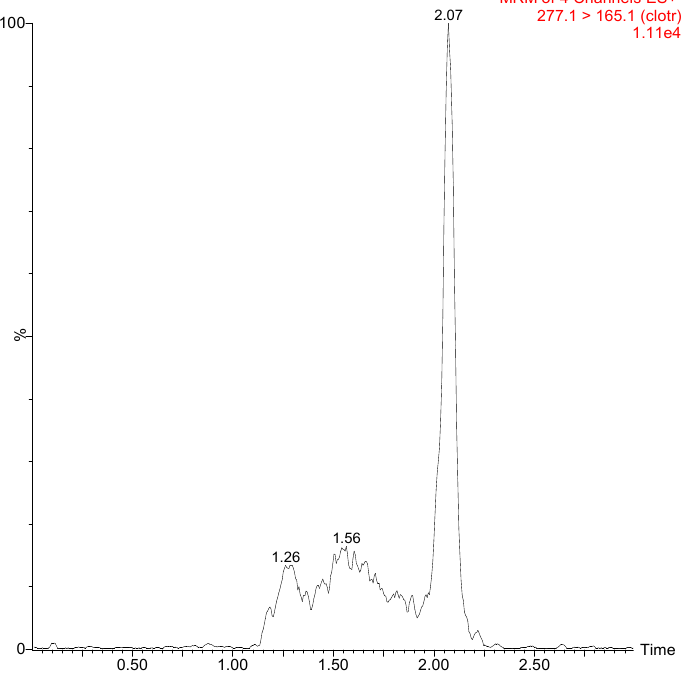
Figure 5. Representative peaks from one healthy volunteer obtained 24 h after day-0 administration of CTZ.